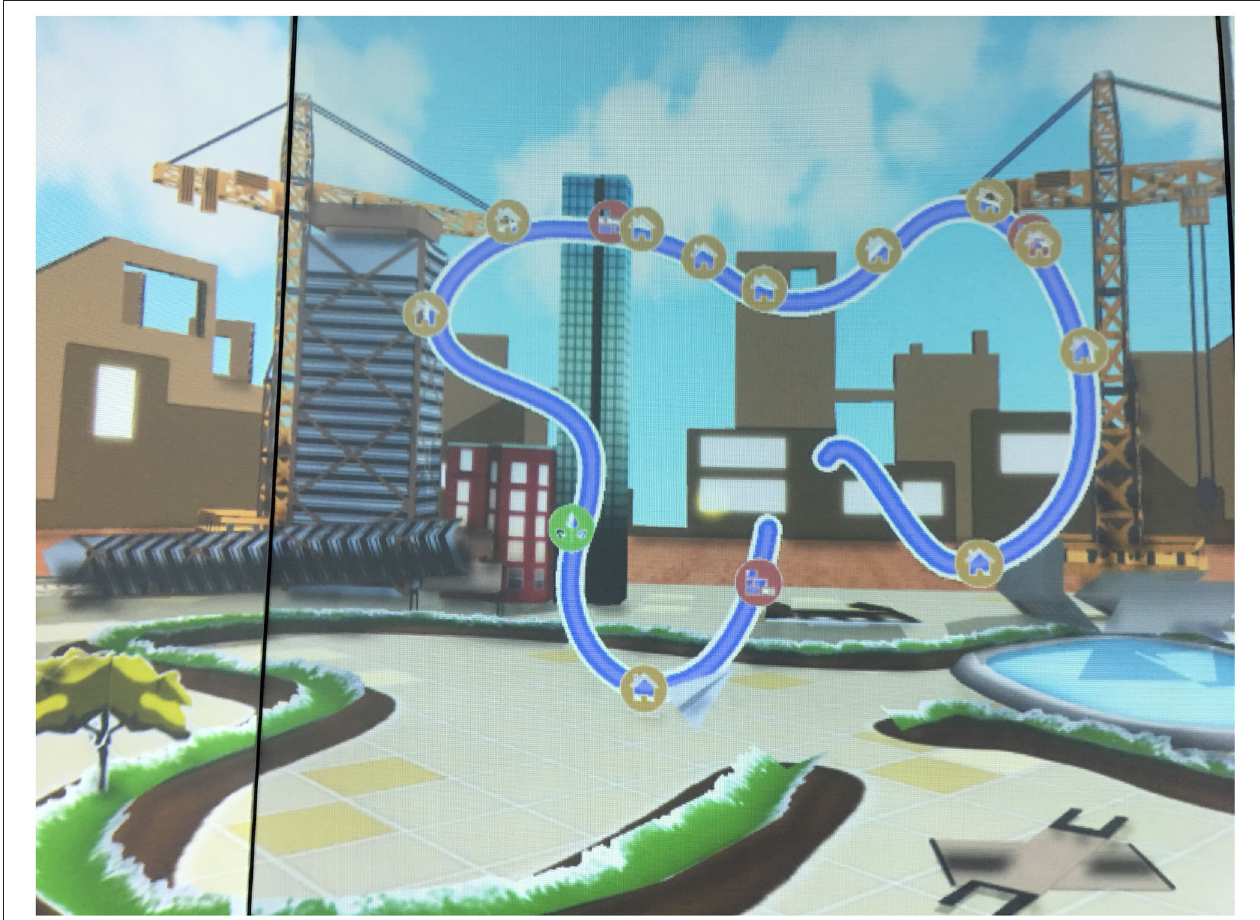
TABLE 1 | Mean and SD of Z-scores for each age group across sessions and within each session.